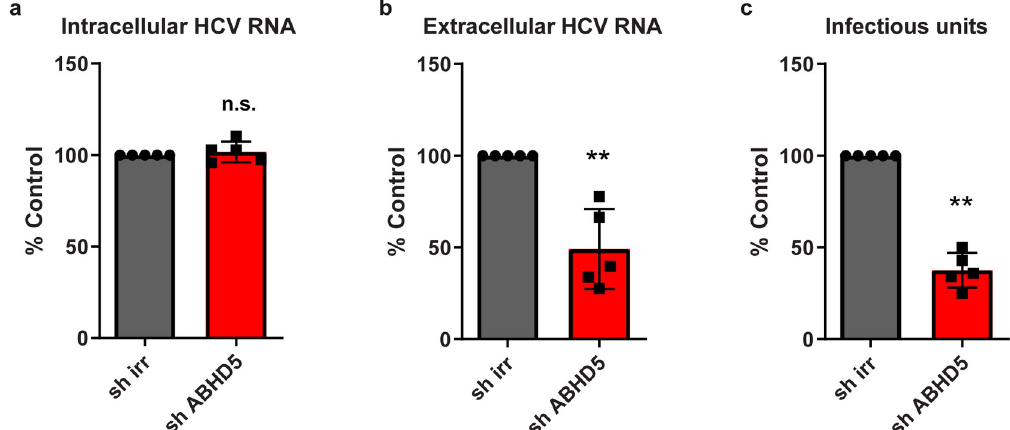
Fig 6. WT HCV also depends on ATGL-mediated lipid droplet. Lunet N hCD81 cells were lentivirally transduced with an ABHD5-targeting or irrelevant shRNA and infected 72 hours later with HCV Jc1. We harvested 48 hours later the cell lysates and supernatants (n = 5). ( a ) Intracellular HCV RNA was quantified from the cell lysates by qRT-PCR and normalized to the GAPDH housekeeping gene. (b) Extracellular HCV RNA was quantified from the cell culture supernatants by qRT-PCR. (c) Released infectivity was assessed by transferring the supernatants onto Huh-7.5 cells, culturing the cells for 48 hours and immunostaining them for HCV NS5A. We quantified the infected foci automatically as described in the Methods section.